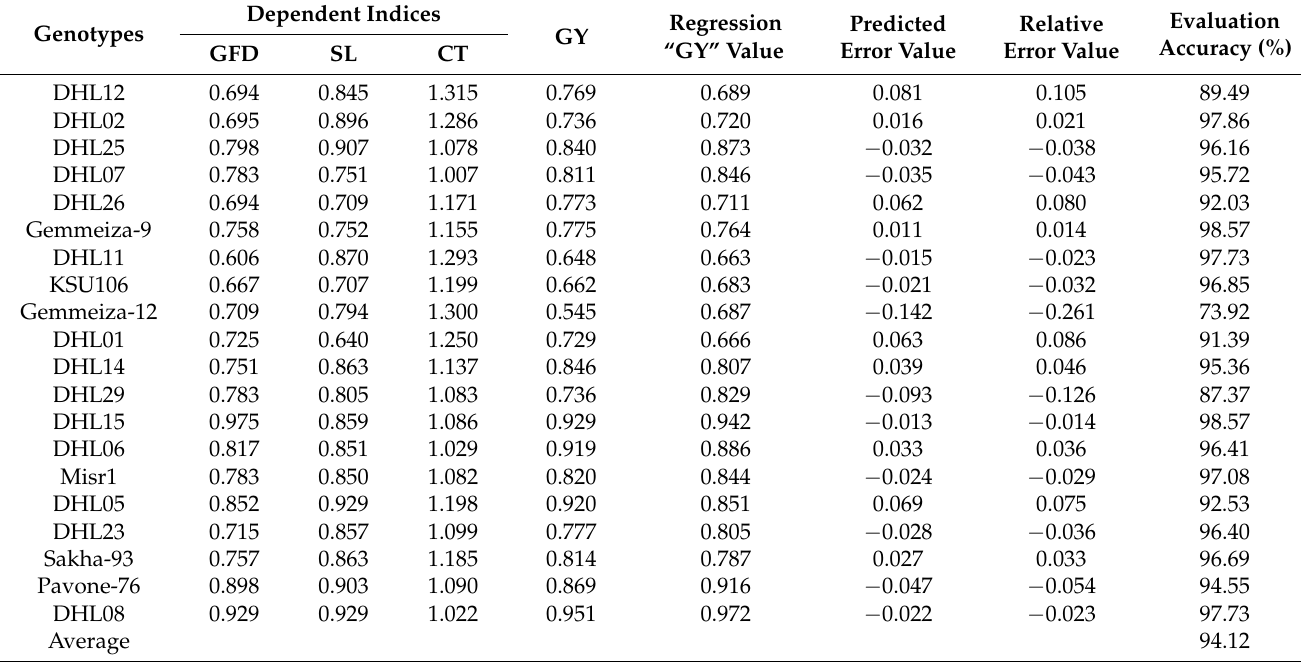
Table 6. The stepwise linear regression analysis was applied to establish optimal regression equation (GY) for predictions, residuals, and evaluation accuracy